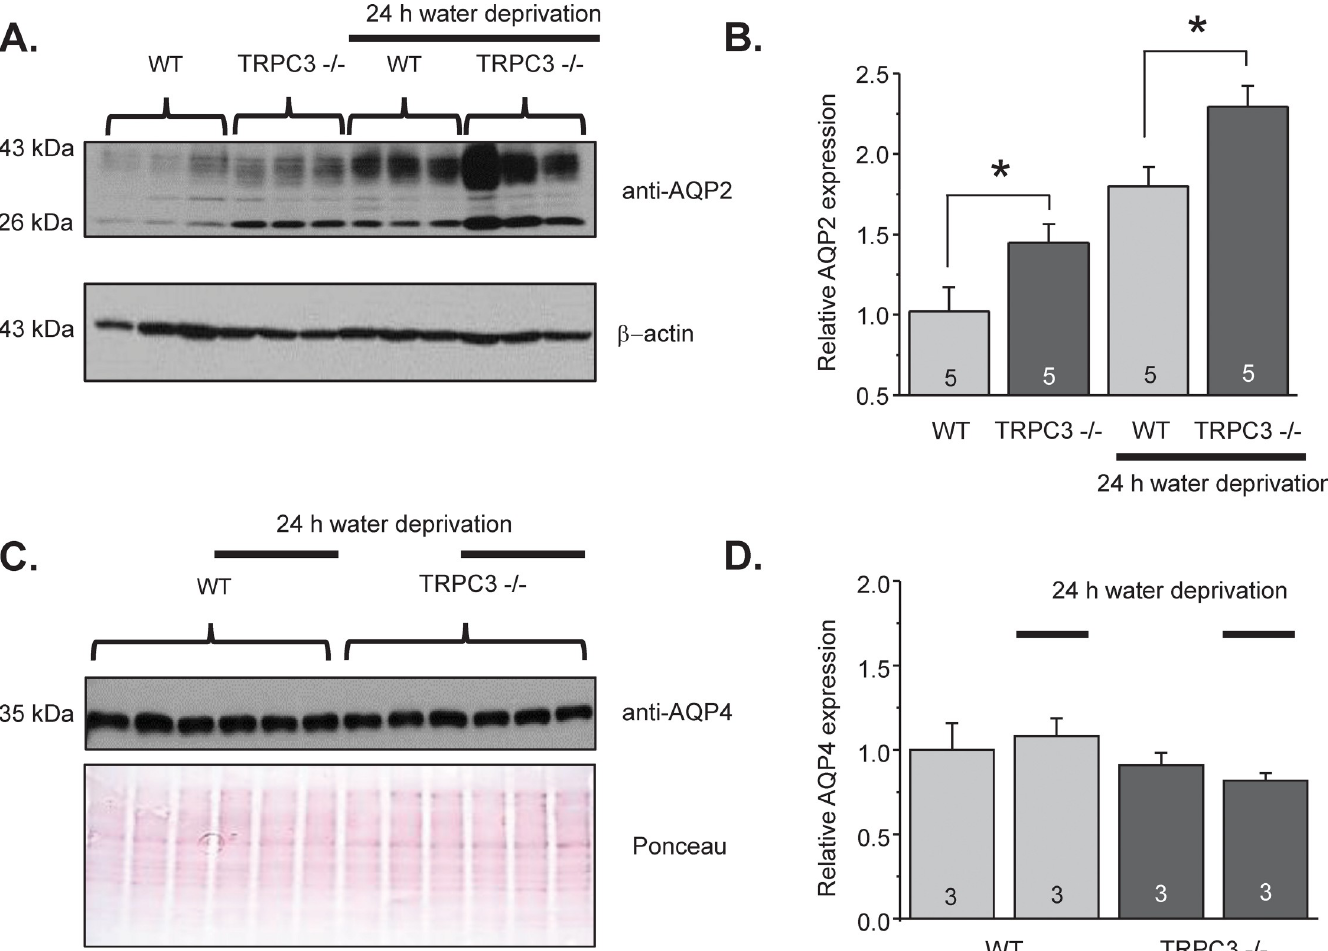
Fig 5. Increased renal abundance of AQP2 but not AQP4 in TRPC3 -/- mice. (A) Representative Western blot from whole kidney lysates of WT and TRPC3 -/- mice at the baseline and after 24h water deprivation probed with anti-AQP2 and anti β -actin antibodies. AQP2 appears as a duplet of the upper glycosylated near 37 kDa and lower non-glycosylated near 29 kDa bands. Each kidney was from separate animal. ( B ) Summary graph comparing total renal AQP2 expression (both glycosylated and non-glycosylated forms) in WT and TRPC3 -/- mice from Western blots similar to that shown in (A) Intensities of AQP2-reporting bands were normalized to the intensities of the respective actin bands. � —significant increase versus respective WT values. (C) Western blot from whole kidney lysates of WT and TRPC3 -/- mice at the baseline and after 24h water deprivation (indicated by a line) probed with anti-AQP4 antibodies. The Ponceau red staining of the same nitrocellulose